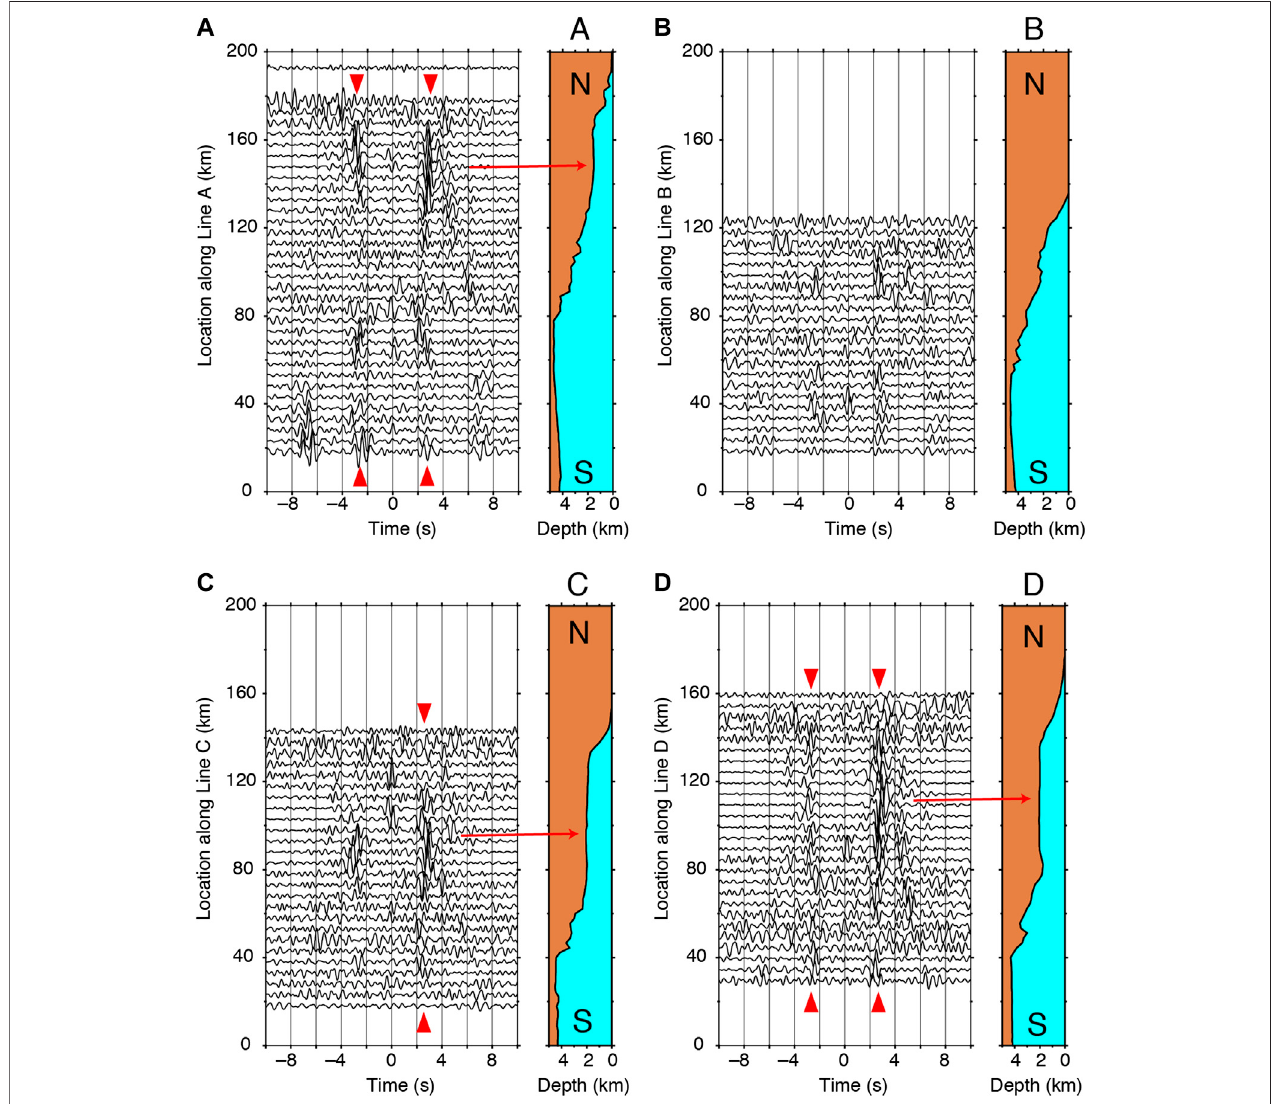
FIGURE6| P waveretrievalat1 – 3 Hz. (A) Z-ZCCFsforpairswhoseseparationdistanceis5 kmarealignedalonglineA( Figure1 ).Redtrianglesrepresent P wave retrievals, and red arrow indicates the location where the P wave is retrieved, which corresponds to the fl at bathymetry region. Right panel shows the bathymetry along the line A. (B) Same as (A) , but for line B. (C) Same as (A) , but for line C. (D) Same as (A) , but for line